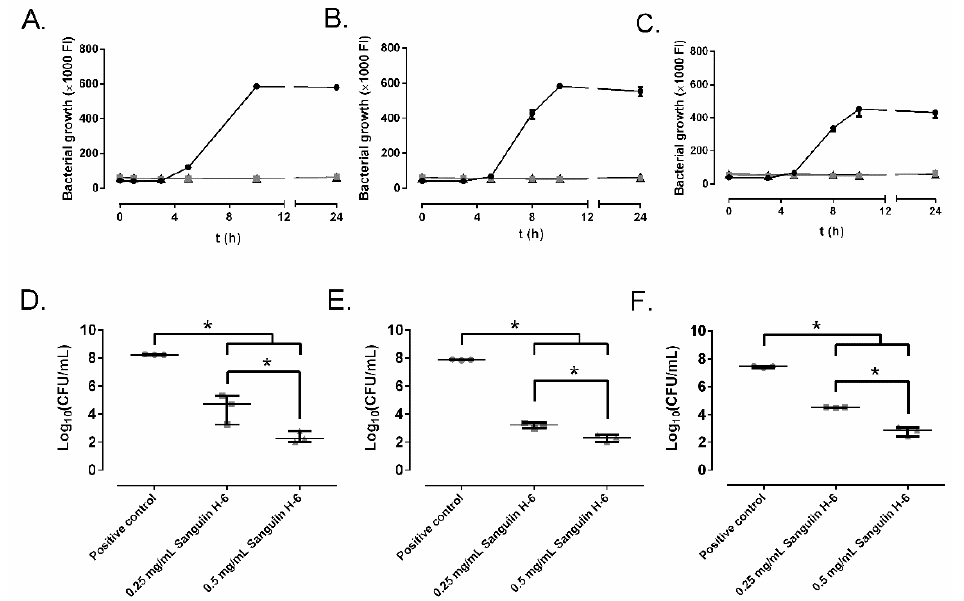
Figure 3. The effect of different concentrations of sanguiin H-6 on SAP231 ( A , D ), MRSA 1 ( B , E ), and MRSA 2 ( C , F ) growth: control (circle), 0.25 mg/mL (square), and 0.5 mg/mL (triangle) over time ( A – C ) and at 24 h ( D – F ). *: p -value < 0.05 for Wilcoxon test.